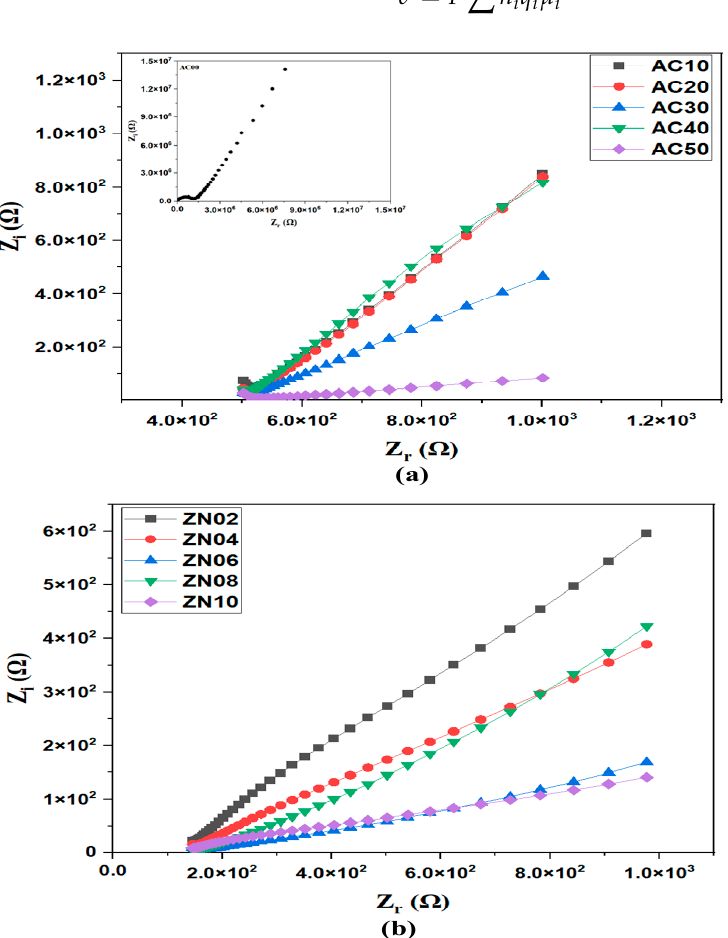
Figure 6. Room temperature Nyquist plots for ( a ) MC/PC/NH 4 Cl SPEs ( b ) MC/PC/NH 4 Cl/NCSPEs. Inset shows the Nyquist plot of MC/PC film.